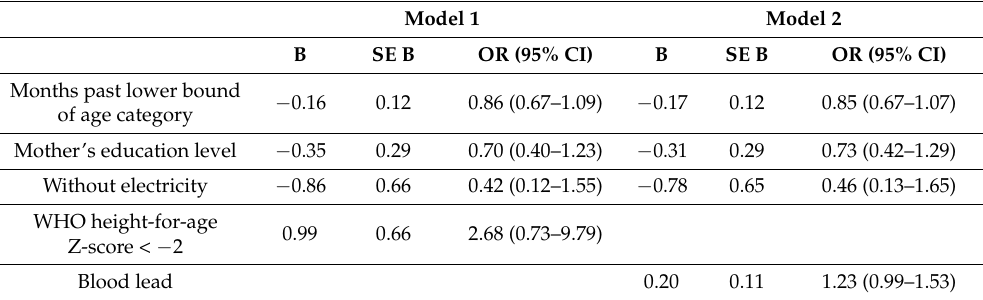
Table 4. Logistic regression analyses to predict failing developmental